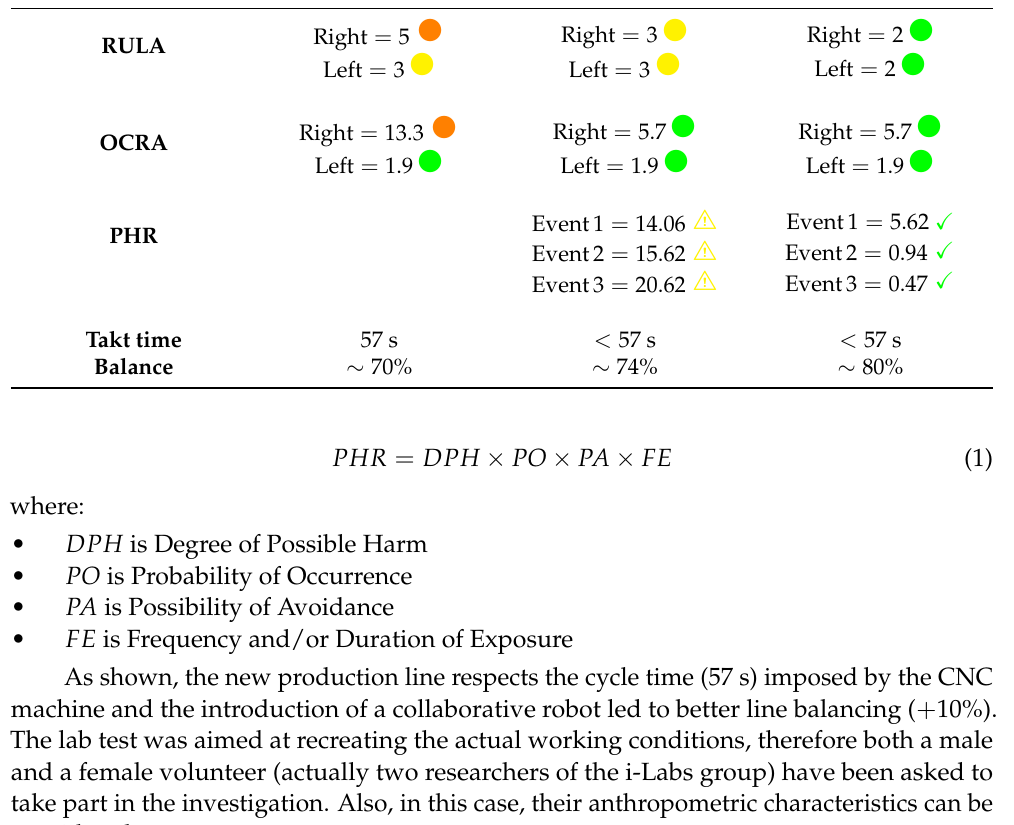
Table 1. Performance comparison between the "as-is" workstation, the preliminary concept of cooperative robotic cell and the final prototype .